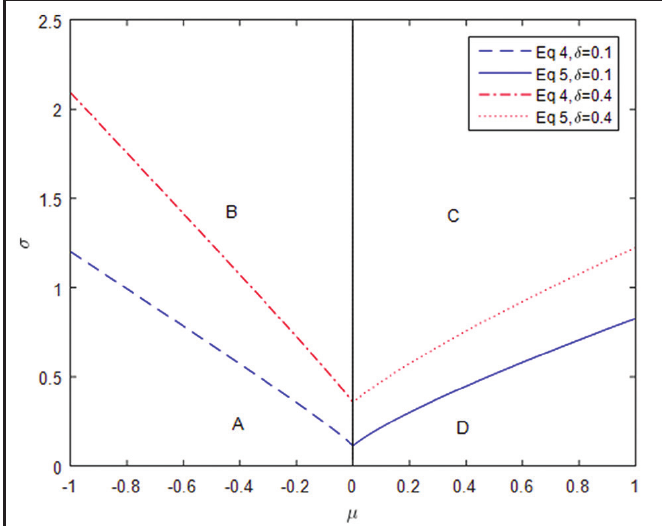
Figure 2 Theoretical prediction of trial period policy, heterogeneous